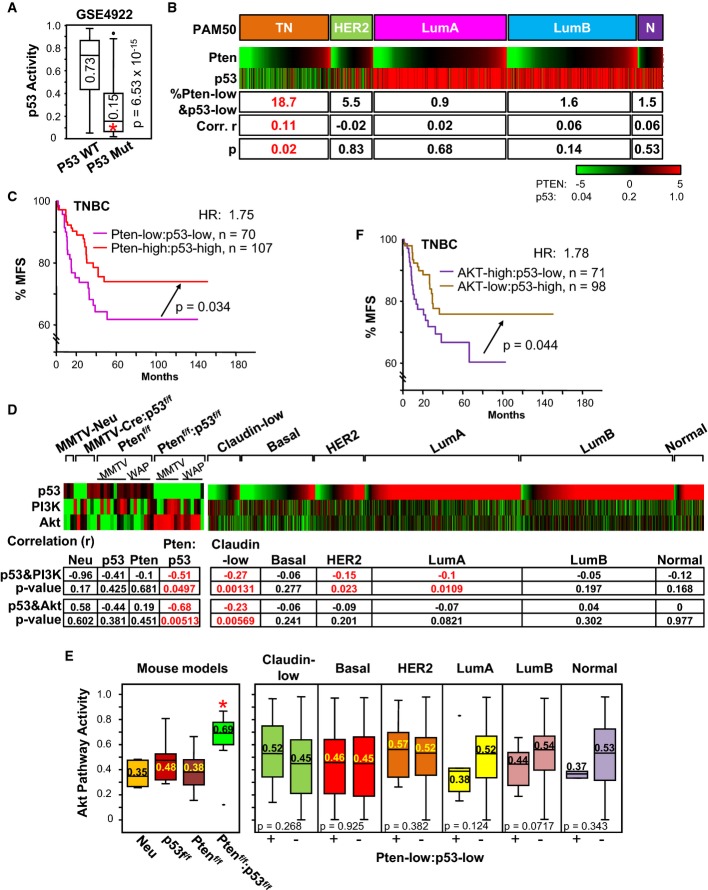
Correlation between Pten/p53 status and AKT pathway activity in BC and effect on clinical
outcomeBox plot for p53-pathway activity in p53 wild-type and p53 mutant tumors from GSE4922. Median
value of p53-pathway activity for p53 mutant, 0.15, is lower than for wild-type tumors (0.73;
P = 6.5 × 10−15,
Mann–Whitney U-test).Pten gene expression and p53 pathway activity in human BC (PAM50 classification). Triple negative
(TN) comprises claudin-low, basal-like and other subtypes. Number of tumors per group: TN, 471
(claudin low, 141; basal-like, 330); HER2+, 218; LumA, 687; LumB, 672; Normal,
131. Percentage of samples with low Pten expression and low p53 pathway activity (Pten-low and
p53-low) is indicated for each subtype. Pearson's correlation (r) with
statistical significance (P-value) for Pten gene expression versus p53 pathway
activity is shown for indicated BC subtypes. Only TNBCs exhibited significantly higher % of
samples with Pten-low and p53-low
(P ≤ 5 × 10−6 relative
the other subtypes) as well as positive correlation
(P = 0.02).Kaplan–Meier metastasis-free survival (% MFS) analysis showing that TNBC patients
with Pten-low:p53-low tumors have poorer prognosis than Pten-high:p53-high tumors
(P = 0.034, Wilcoxon).p53, PI3K and AKT pathway activities in mouse models (left) and human BC subtypes (right). Note
the high and significant correlations of p53 and PI3K as well as p53 and AKT pathways in mouse
Pten/p53 tumors and human claudin-low TNBC.Box plot of AKT pathway activity in indicated mouse and human tumors. For mouse tumors, AKT
pathway activity was significantly higher in Ptenf/f:p53f/f compared to
p53f/f tumors (*P = 0.04,
Kruskal–Wallis). Comparisons with other models gave lower P-values. For
human BC, AKT signaling was calculated for Pten/p53-low tumors (left boxes) versus all other tumors
(right boxes). Note the high Akt pathway activity in mouse Pten/p53 tumors relative to other models
(P < 0.04) and a trend toward increased Akt signaling in human
Pten-low/p53-low versus other claudin-low tumors (P = 0.268).
P-values (Kruskal–Wallis) are shown.Kaplan–Meier metastasis-free survival (% MFS) analysis showing that TNBC patients
with AKT-high:p53-low tumors have poorer prognosis than AKT-low:p53-high tumors
(P = 0.044, Wilcoxon).